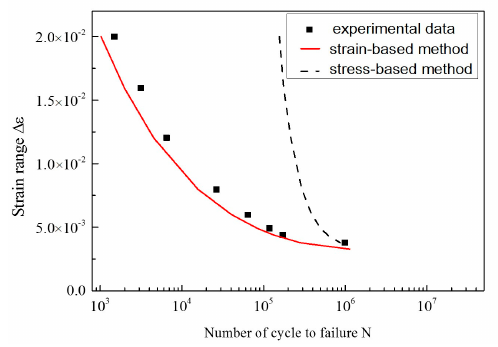
Figure 11. Predicted fatigue life of 316 stainless steel.